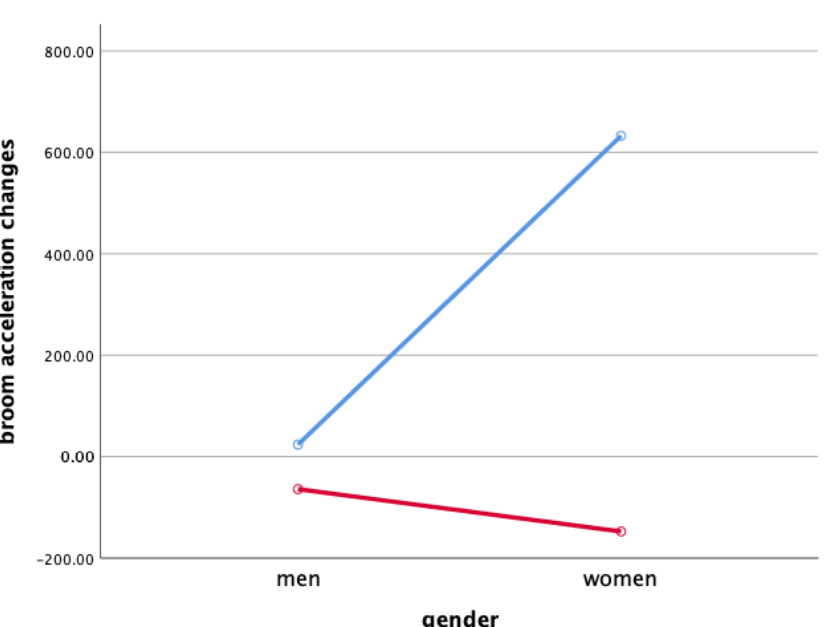
Figure 8. Broom Acceleration Changes When Sweeping(Z)—main effect (mG). Red line: along the axis of motion, blue line: perpendicular to the axis of motion.